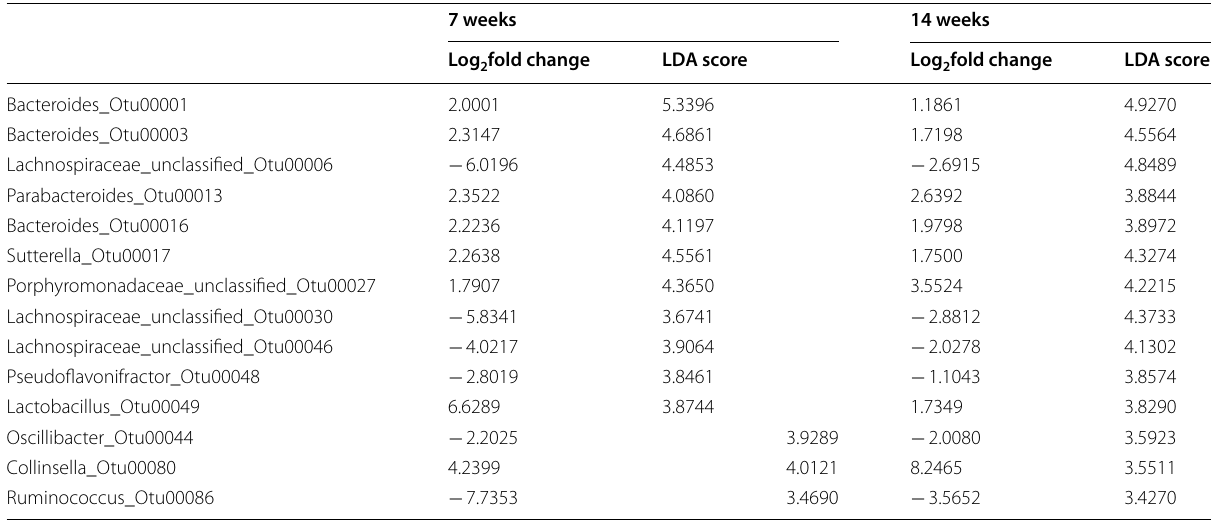
Table 4 Common OTUs altered significantly in CafCaf compared with CafChow offspring at both 7 and 14 weeks